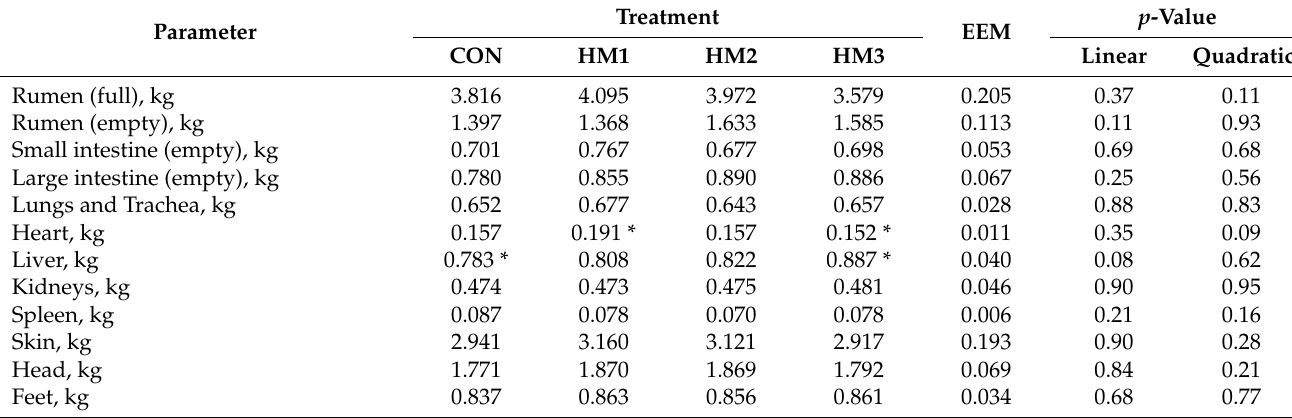
Table 3. Organ weights of lambs supplemented with a polyherbal mixture 1 during the final fattening period.